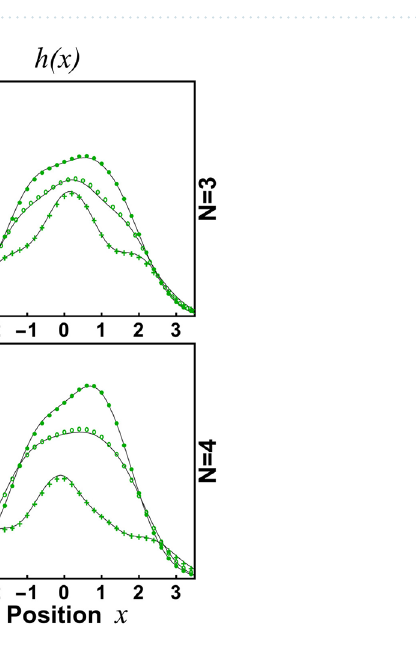
ρ( x , ρ( x , 0 ) x ) and h ( x ) = − =